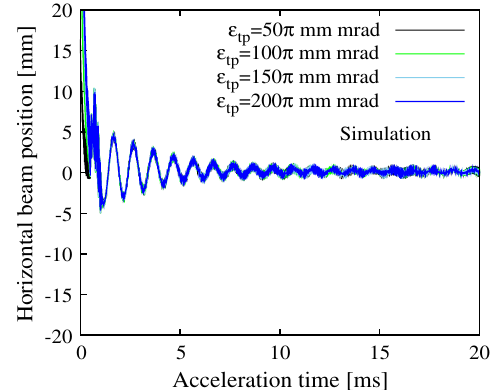
FIG. 14. Simulated (left) and measured (right) results of beam instability suppression by the effect of strong space charge (peaky bunch) for 0.375 MW beam power. The beam tends to be stable (green) when the space charge effect is strengthened by turning off the second harmonic rf voltage (apply V 1 only) and by not performing longitudinal injection painting.